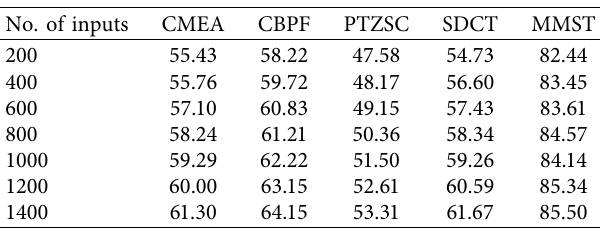
Table 6: Comparison of soil microorganism management.